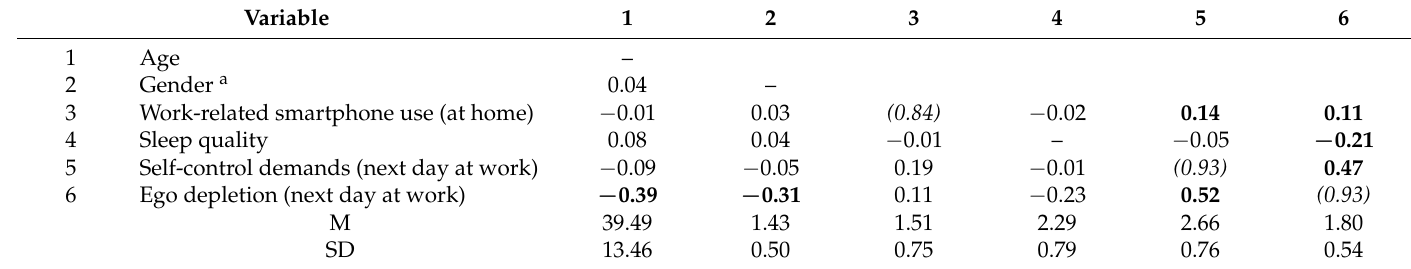
Table 1. Means, standard deviations, internal consistencies (Cronbach’s Alpha), and intercorrelations of study variables.